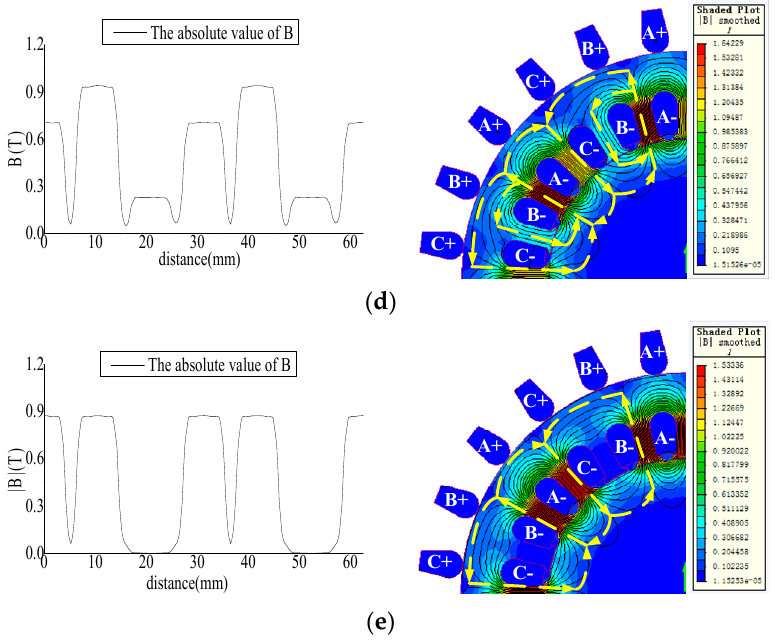
Figure 4. Air-gap flux density and magnetic field distribution at different times: ( a ) 0° times, ( b ) 30° times, ( c ) 60° times, ( d ) 75° times, ( e ) 90° times.